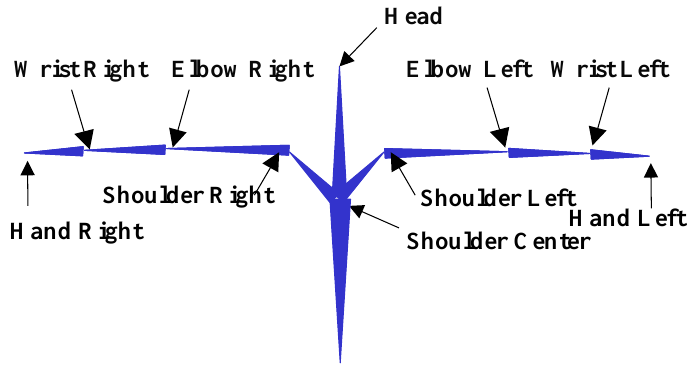
Figure 2. Skeleton model: 10 upper body components.